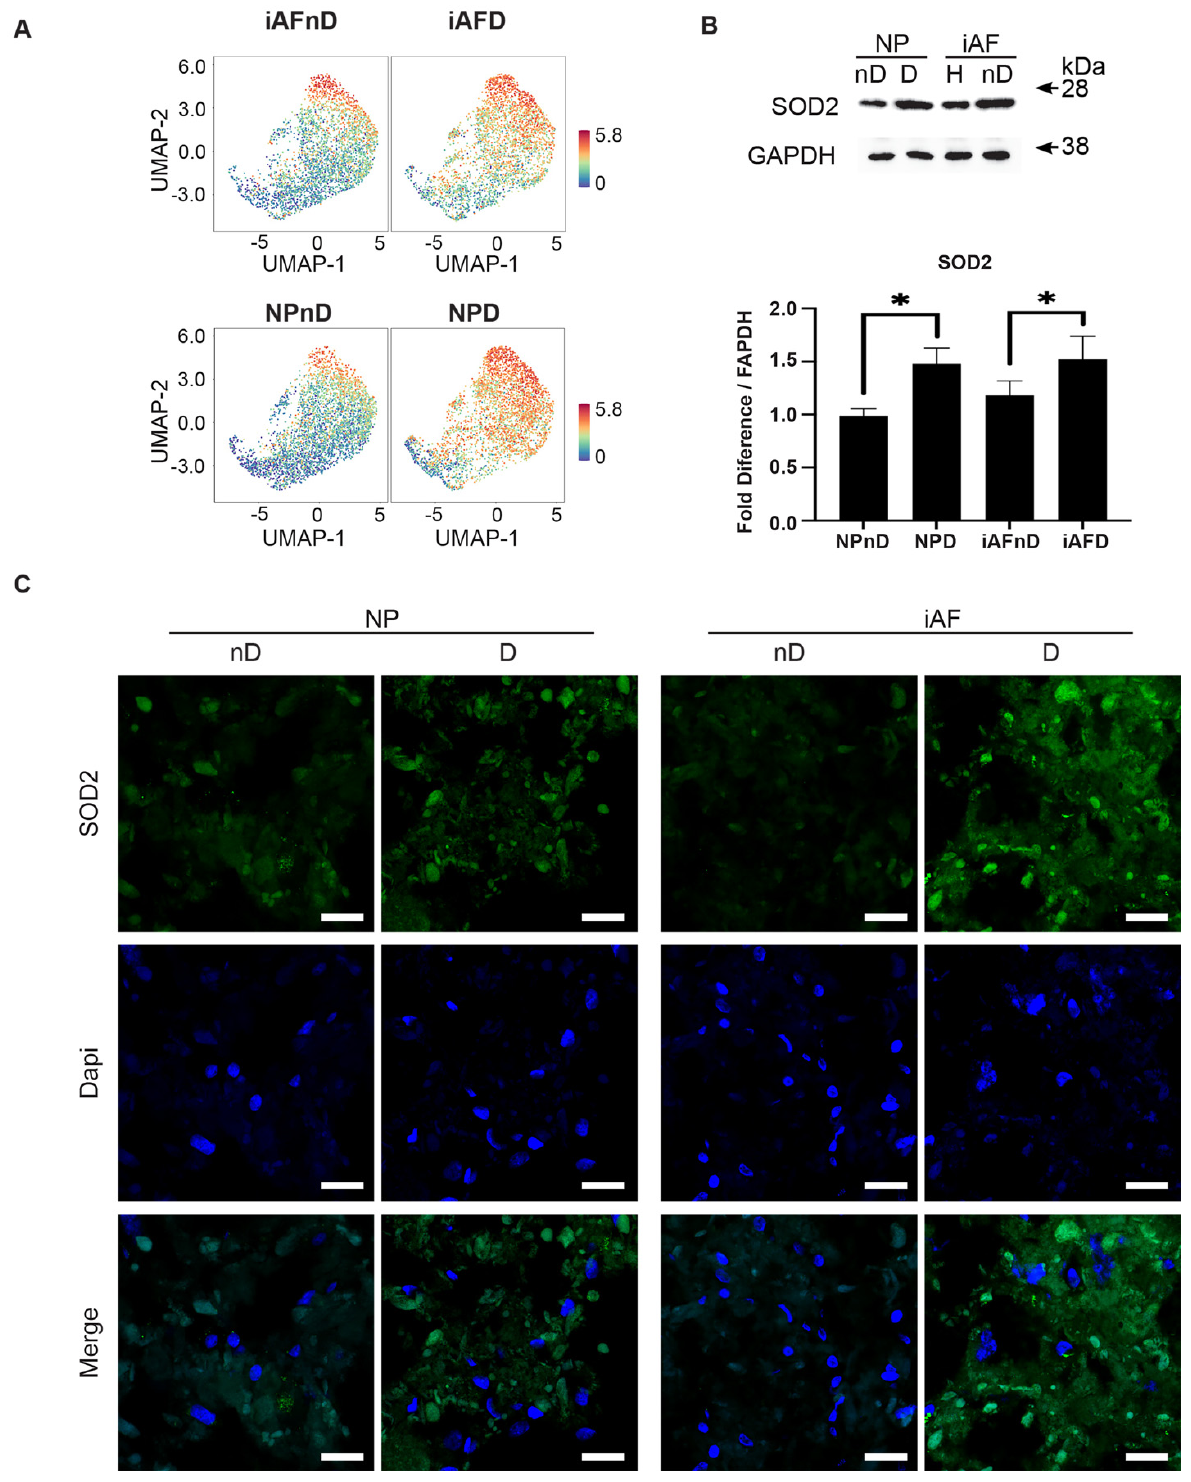
Figure 7. Validation of selected cell type and degeneration markers. ( A ) UMAP highlighting SOD2 gene expression at the single-cell level in iAF and NP nD and D discs of the same individual. ( B ) Western Blot analysis of cell lysates from 5 additional individuals normalized to GAPDH (n = 5). ( C ) Immunohistochemistry staining of SOD2 (in green), Dapi (in blue) and merged images of cells from 5 additional individuals (scale = 100 µm, n = 5 biological replicates). Graphs are presented as mean ± SEM. * p < 0.05